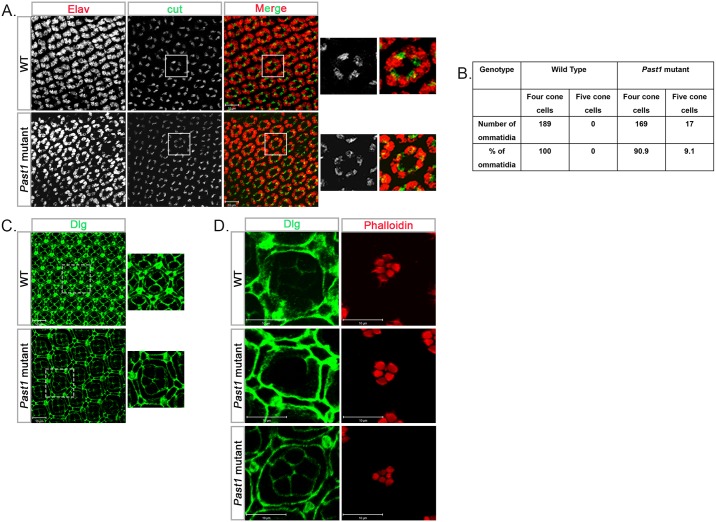
Specification of cone and inter-ommatidial cells in Past1 mutant eyes.(A) Elav (grey, or red in the merge) and cut (grey, or green in the merge) staining of wild type and Past1110-1 homozygous mutant early-mid pupal eyes (42-48h after puparium formation). Shown are Z-projections of confocal sections. The enlarged images on the right of each frame show an ommatidium with four cone cells in wild type and an ommatidium with five cone cells in Past1110-1mutant eyes. (B) Quantification of four or five cone cells in wild type (n = 189) and Past1110-1mutant (n = 186) ommatidia; P < 0.001. (C) Dlg (green) staining of wild type and Past1110-1mutant early-mid pupal eyes (42-48h after puparium formation). Shown are Z-projections of confocal sections. The enlarged images on the right of each frame show an ommatidium with nine inter-ommatidial pigment cells and four cone cells in wild type and an ommatidium with nine inter-ommatidial pigment cells and five cone cells in Past1110-1mutant eyes. (D) Dlg (green) and phalloidin (red) staining of wild type and Past1110-1mutant late pupal eyes (85-96h after puparium formation). Different focal planes of the same ommatidium, presenting: upper sections of the ommatidia for Dlg and lower sections for phalloidin.